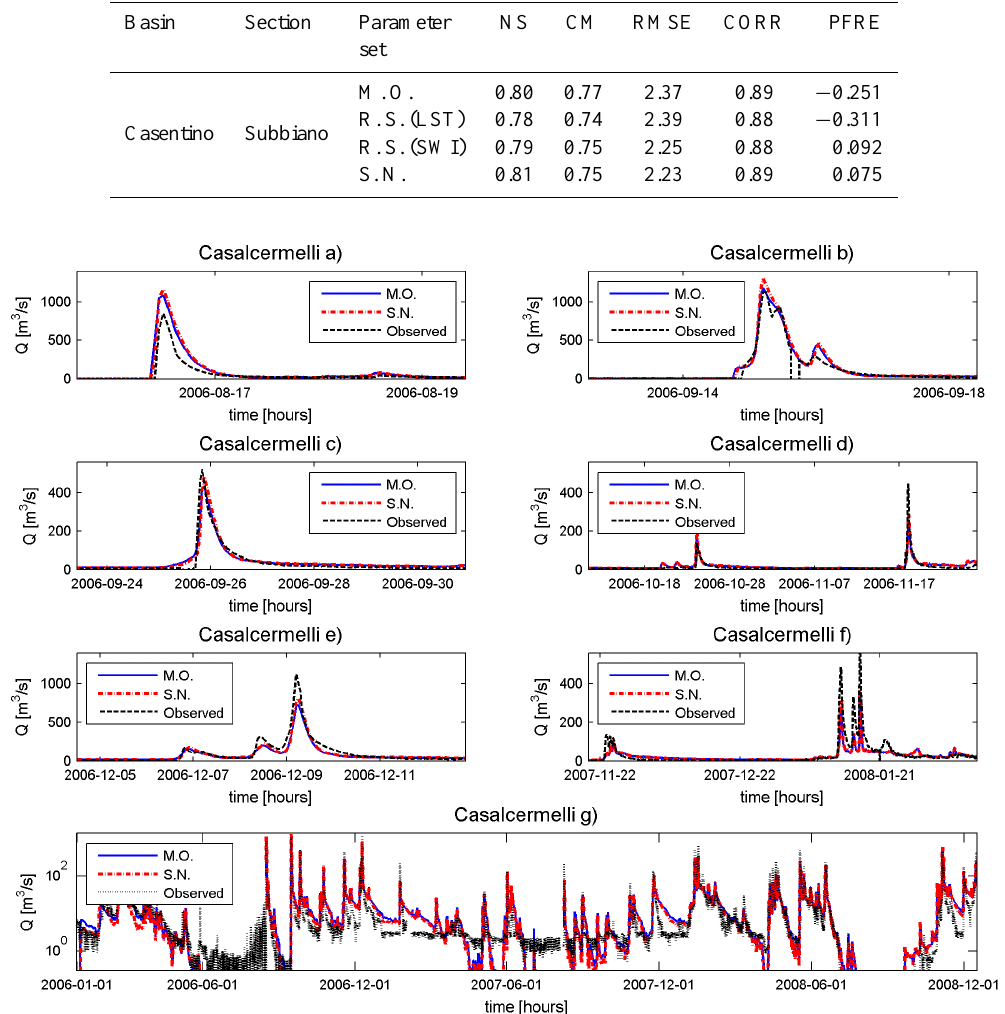
Figure 12. Observed streamflow for the Orba basin compared with simulations obtained using the M. O. and S. N. parameter sets for the period 2006 to 2008. Time is reported on x axis and streamflow on y axis. The bottom subpanel shows the entire period with log scale on y axis. The other subpanels show the main flood events with linear scale on y axis.